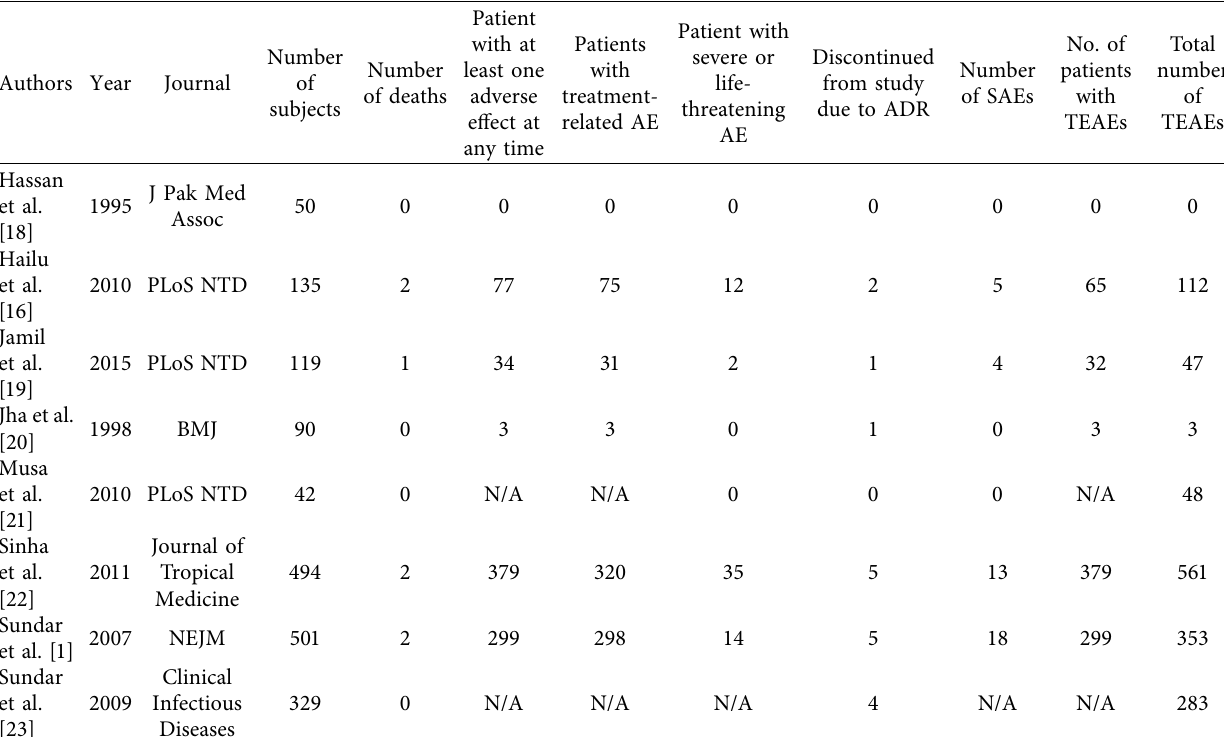
Table 3: Number of patients developing AEs during treatment.